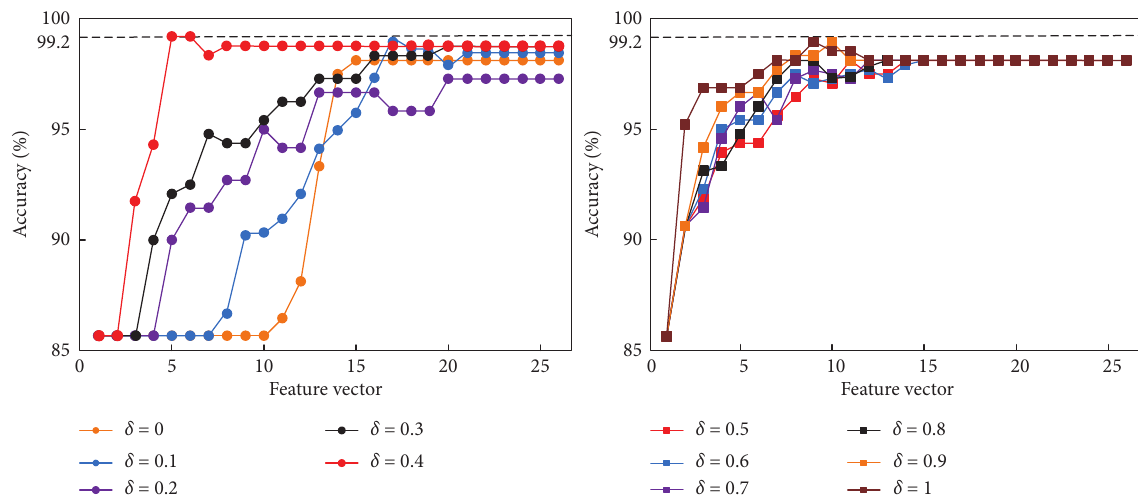
Figure 6: Different feature subset classification accuracy rate curves corresponding to different δ